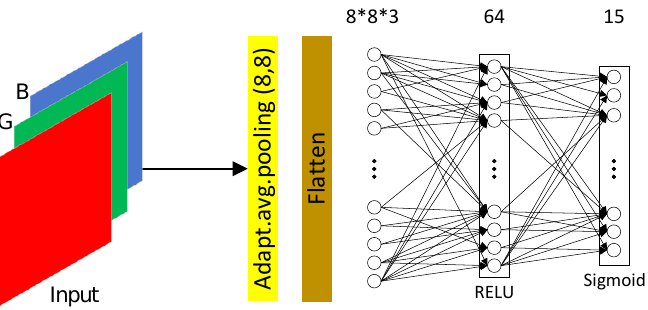
Figure 5. The schematic diagram of the adaptive pre-processing module. The APM module inputs the RGB image and outputs the hyperparameters adapted to the specific task for the image enhancement processing.